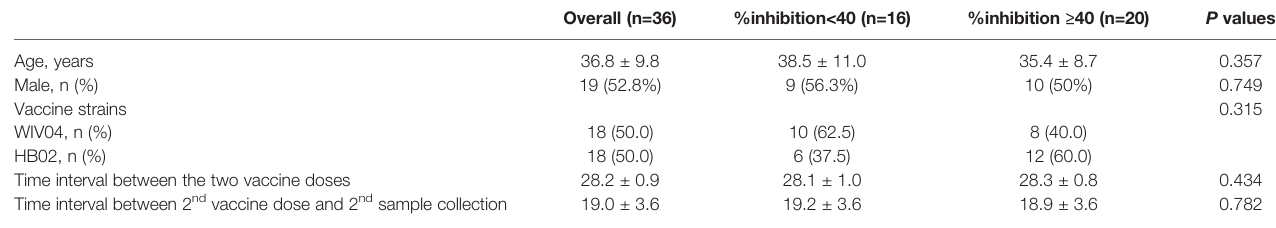
TABLE 1 | Basic characteristics of the study